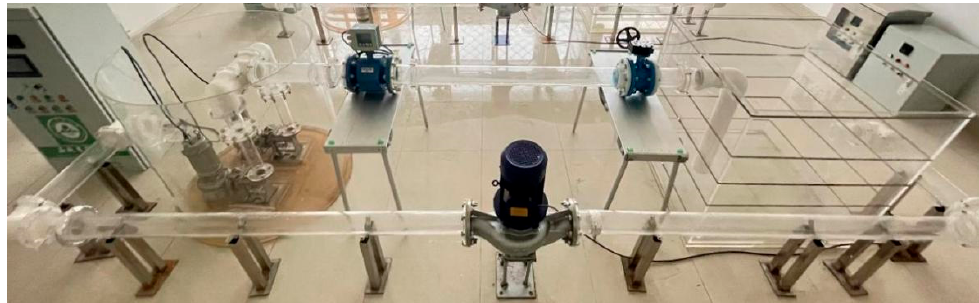
Figure 5. Physical diagram of centrifugal prefabricated pumping station test bench.